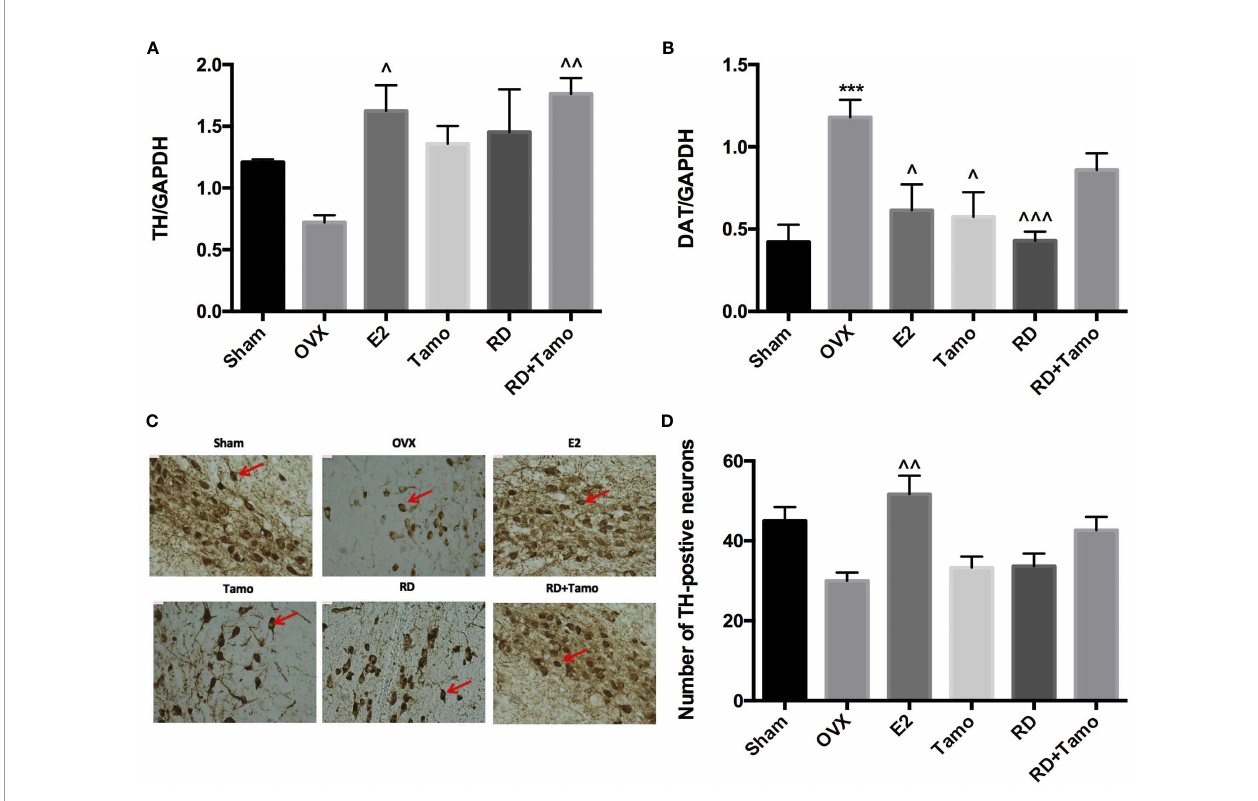
FIGURE 3 | Estrogenic effects of RD, tamoxifen, and their combinations in the central nervous system of mature ovariectomized rats. Upon treatment, striatum was collected at euthanasia. mRNA expression of tyrosine hydroxylase ( TH ) (A) and dopamine transporter ( DAT ) (B) were measured by real-time PCR. TH-positive cells in the substantia nigra were visualized by IHC (×100) (C) and quanti fi ed (D) . Data were expressed as mean ± SEM. n = 6 to 10. *** p < 0.001 vs. Sham; ^ p < 0.05, ^^ p < 0.01, ^^^ p < 0.001 vs. OVX. p -value of two-way ANOVA: 0.4257 for TH/GAPDH, <0.0001 for DAT/GAPDH, 0.35531 for TH-positive